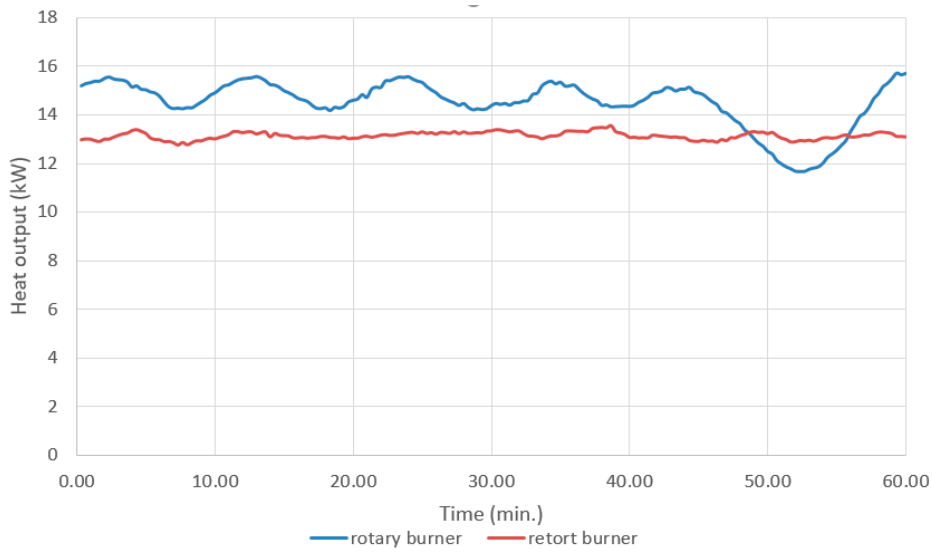
Figure 6. Typical time courses of heat output of heat source in different types burners from experi- ments.